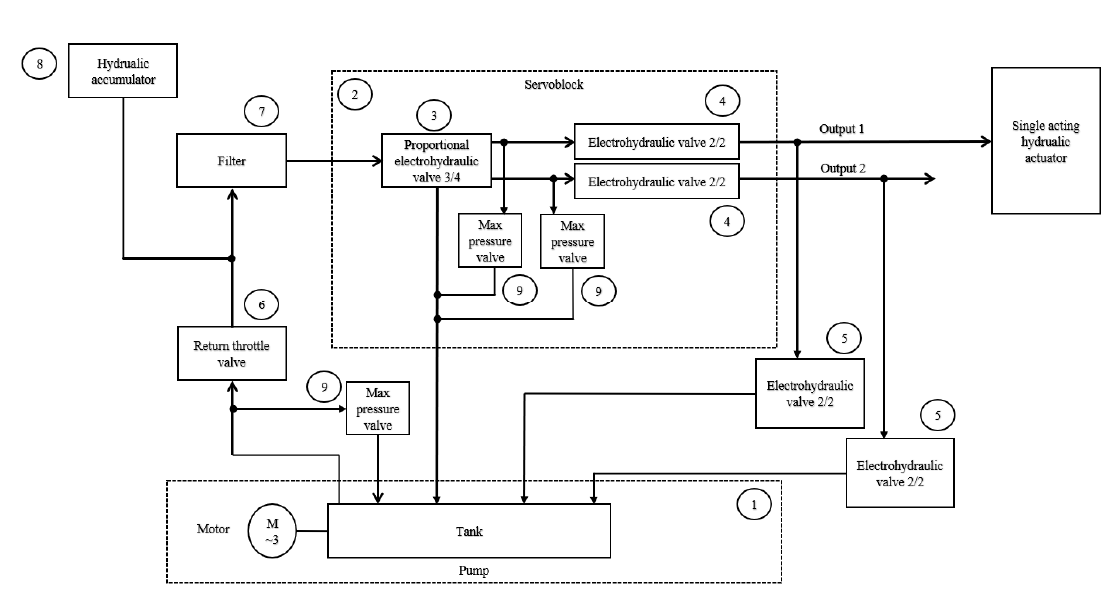
Figure 4. Scheme of hydraulic subsystem.